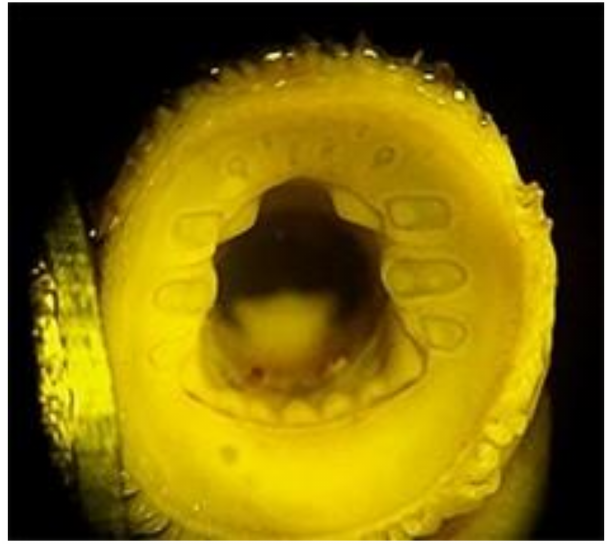
Figure 3. Oral disc of the European river lamprey Lampetra fluviatilis (Kamenka